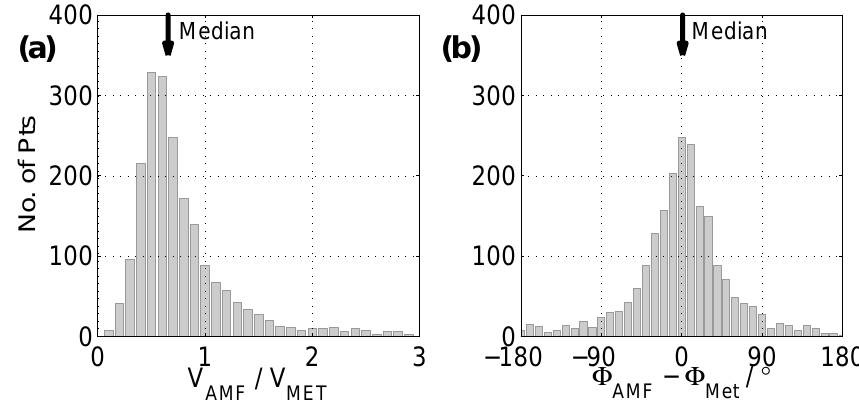
Fig. 10. Histogram of the ratios of the wind speeds (a) and differences of the wind directions (b) between Andenes MF and Andenes Meteor radars in the altitude range of 82 and 86km (July 2003).